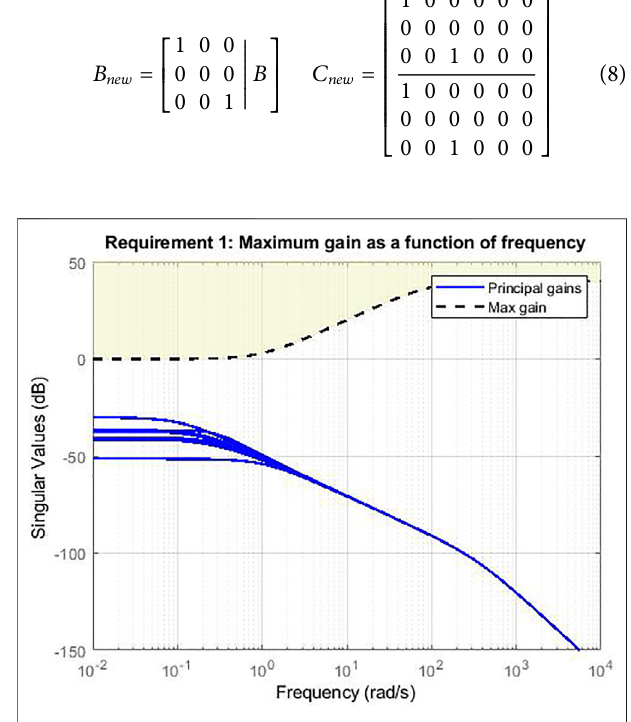
FIGURE 4 | Magnitude Bode diagram of the transfer functions of the MIMO system. Simulation in Matlab with